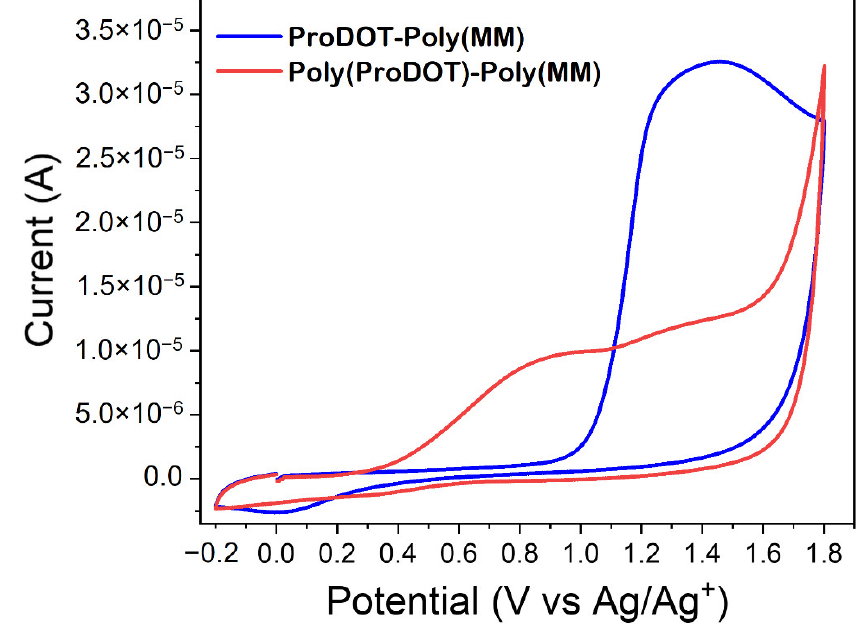
Figure 6. Cyclic voltammograms of ProDOT-Poly(MM) and Poly(ProDOT)-Poly(MM) brushes. The brushes after oxidative polymerization grafted from quartz surface were char- acterized by UV-Vis spectroscopy (Figure 7) and emission spectroscopy (Figure 8). The UV-Vis absorption spectrum of conjugated Poly(ProDOT)-Poly(MM) exhibits a shoulder between 525 nm and 850 nm and a dominant band with two local maxima at around 310 nm and 400 nm, which are practically absent in the spectrum of the brushes before the conjugation. The deconvolution of the dominant absorption band indicates the presence of at least four peaks (264 nm, 404 nm, 436 nm, and 441 nm) that can be attributed to π - π * electronic transitions of corresponding conjugated chains (Figure S13). The red shoulder of the spectrum shows a band at 722 nm, probably representing π - π stacking and crystallinity within the brushes [68]. It should be stressed, however, that the absorption spectrum interpreted here as a sum of five bands may in fact be composed of a larger number of Gaussian peaks with a narrower full width at half maximum (FWHM) corresponding to oligomers of different lengths. For instance, a broad band with a maximum at 441 nm spans a wide region of UV/UV-vis and completely overlaps with two weaker bands at 404 and 436 nm. Such components may vary in concentration and molar absorptivity, which leads to the formation of rather the band tails, but not the appearance of distinguished maxima. In consequence, a gradual increase in the FWHM of the deconvoluted bands located above 400 nm can be observed.